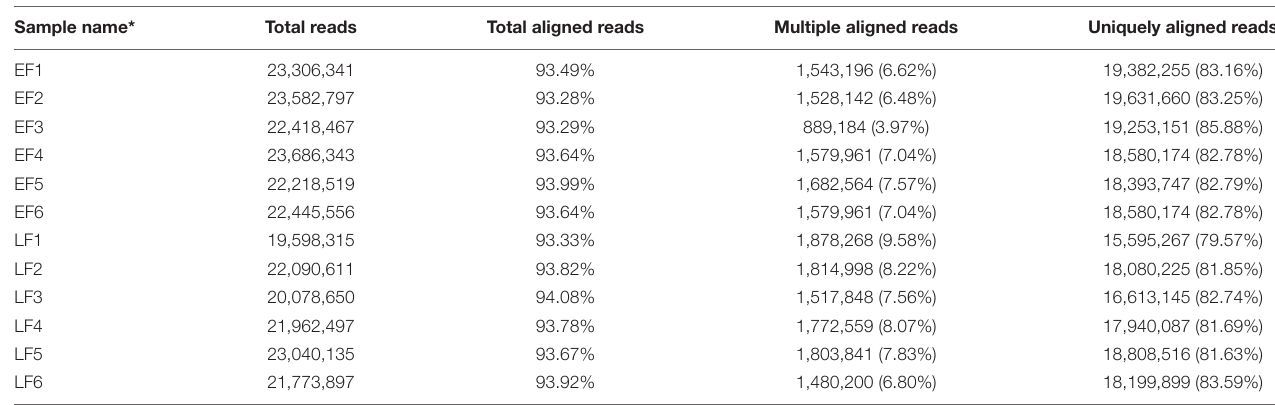
FIGURE 2 | Manhattan plots for genome-wide association study of the feather rate of Shouguang chicks. The red line shows the P value threshold of 1.32e-07 adjusted by the Bonferroni method with total SNP numbers after quality control [0.05/(368,657 + 9,207)]. (A) Manhattan plot for the genome-wide association study of the feather rate with all SNPs throughout the whole genome. (B) Manhattan plot of the Z chromosome for the genome-wide association study of the feather rate. The blue line shows the P value threshold of 5.43e-06 adjusted by the Bonferroni method with SNP numbers of chromosome Z (0.05/9207). TABLE 2 | The summary of clean data